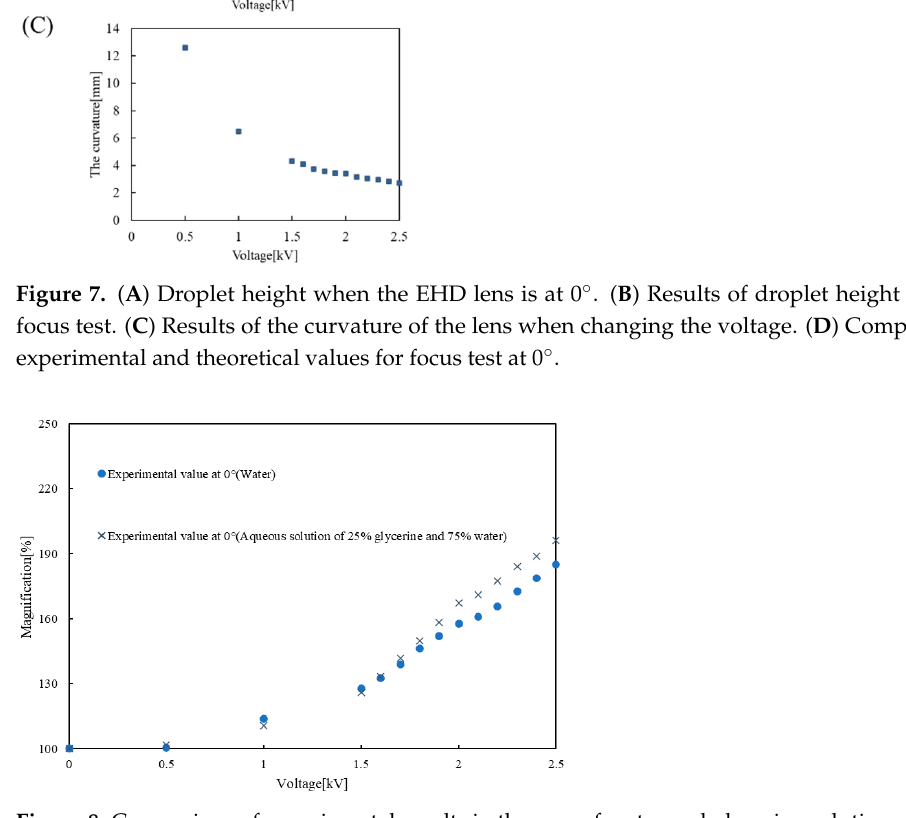
Figure 8. Comparison of experimental results in the case of water and glycerine solution.